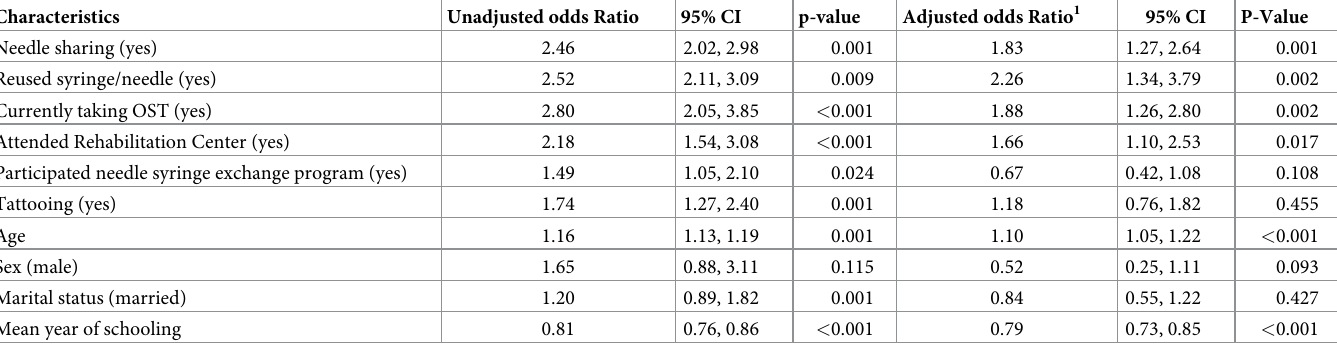
Table 5. Multivariate analysis of injecting risk behavior, prevention exposure with HCV screening